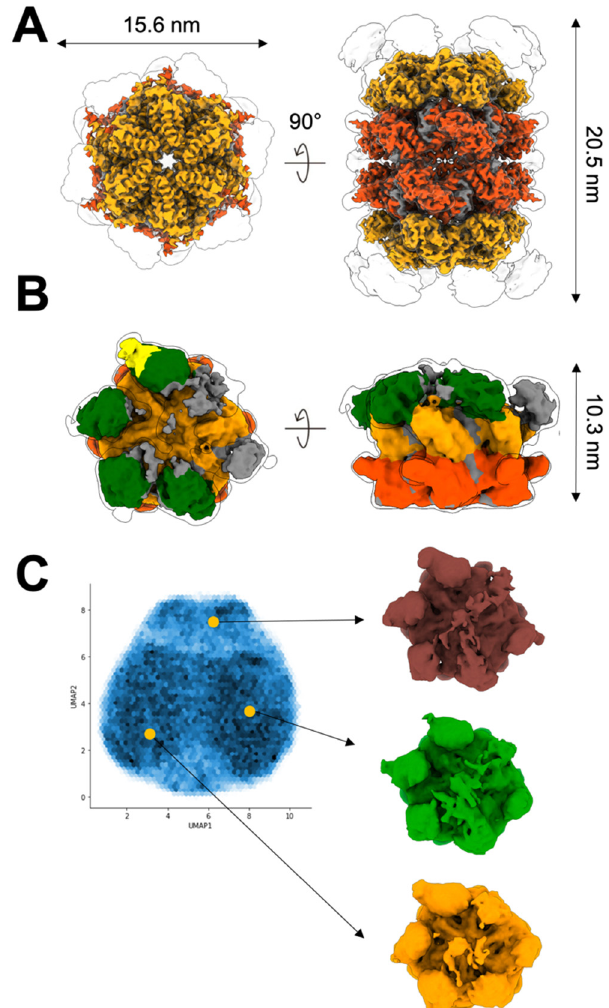
Figure 2. Cryo-EM reconstructions of the p97 R155H dodecamer and the p97 R155H -p47 complex. Cryo- EM densities of ( A ) p97 R155H dodecamer (5.6 σ ) and ( B ) p97 R155H -p47 complex (2.3 σ ). Green, orange, orange-red, and yellow highlight the NTD, D1, and D2 of the p97 R155H and p47 UBX , respectively. Grey color indicates regions where densities could not be assigned. Envelopes are the cryo-EM maps at a lower contour (p97 R155H dodecamer: 2.4 σ ; p97 R155H -p47: 1.6 σ ). ( C ) UMAP (uniform manifold approx- imation and projection) representation of a generative neural network analysis of the p97 R155H -p47 cryo-EM density. Blue intensities represent the distribution of particle images in the embedded la- tent space. Three different 3D averages (brown, green and light orange) were calculated from the chosen clusters (orange circles).